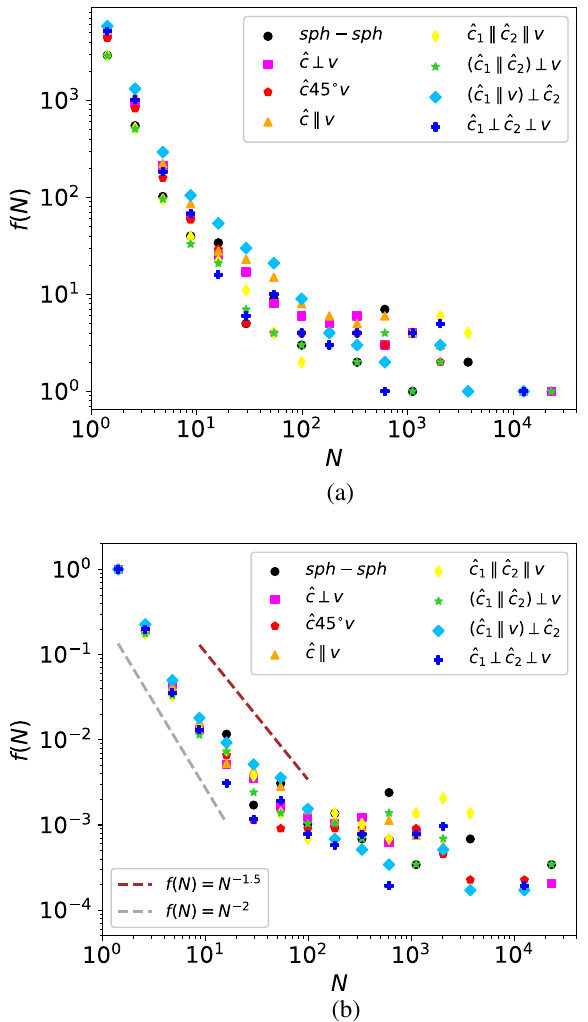
Figure 5. ( a ) Size distribution of fragments, f ( N ), for collision velocity of v = 15 m/s and the collision geometries indicated, cf. Table 1. ( b ) Data are normalized to f ( 1 ) = 1 . Dashed lines show power-law behavior, Eq. (5), with τ = 2 and 1.5 for